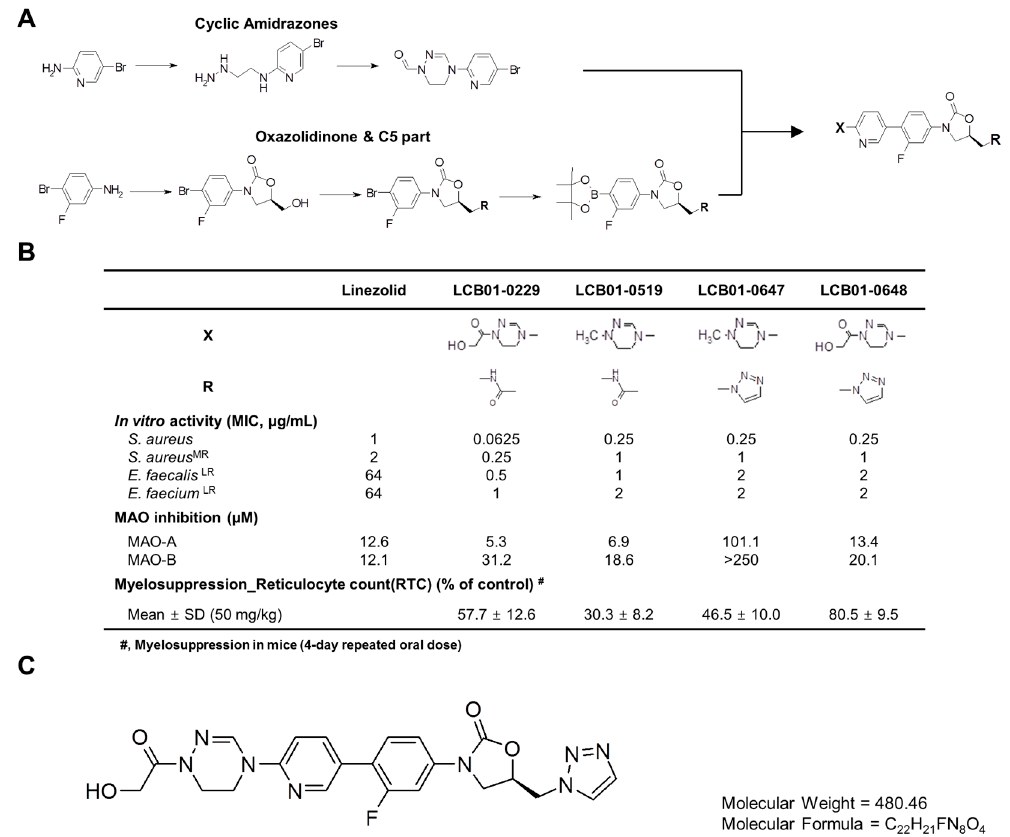
Figure 1. Chemical structure of LCB01-0648. ( A ) Synthetic scheme of oxazolidinones containing cyclic amidrazone; ( B ) Structure–activity relationship of cyclic amidrazone; ( C ) Structure of LCB01-0648.